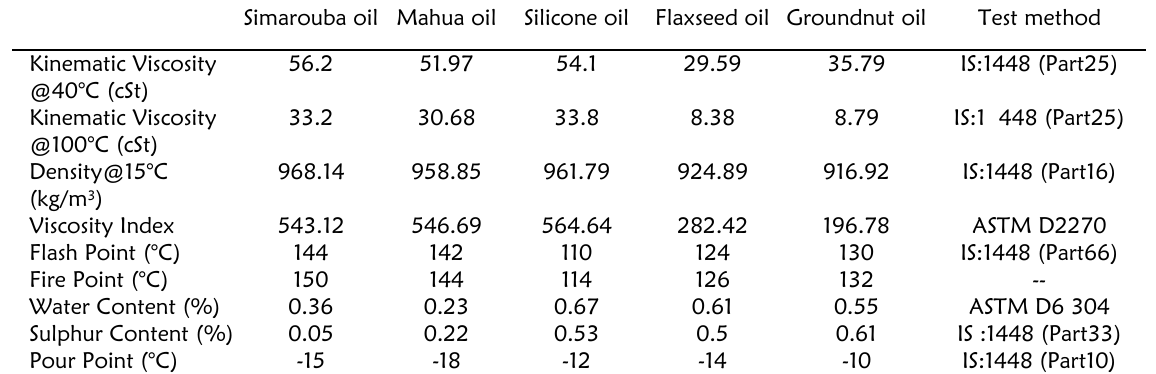
Table 1: Properties of